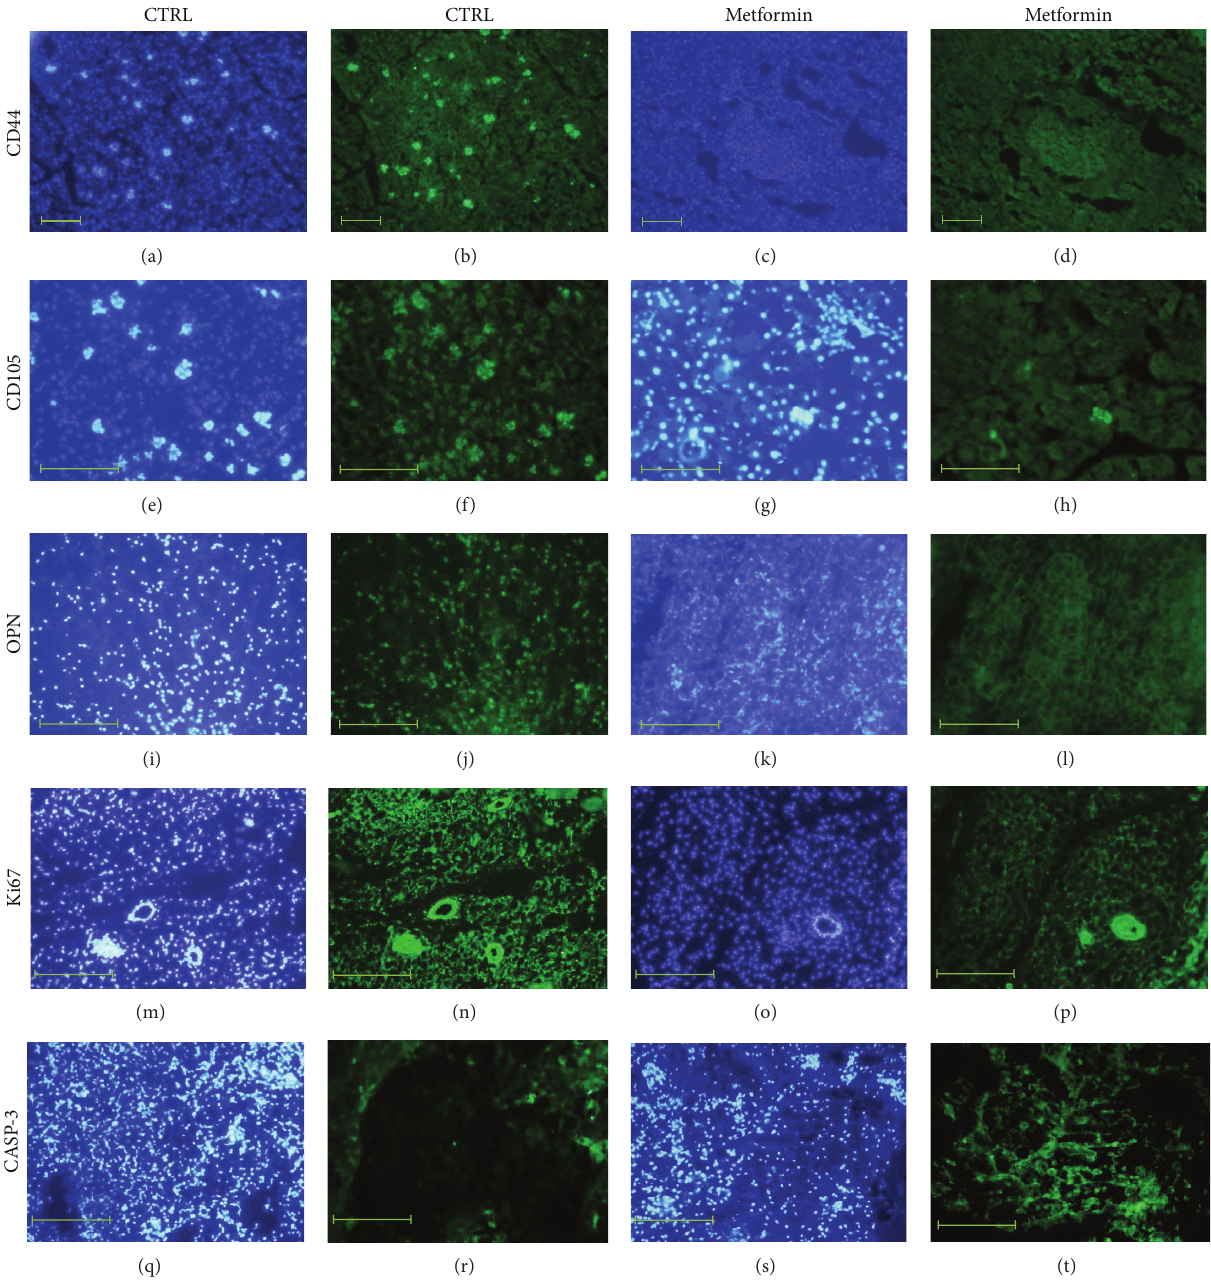
Figure 11: Results of immunohistochemical staining for CD44, CD105, OPN, Ki67, and caspase-3 (CASP-3). In order to recognize the nuclei location,theimagesofspecificstainingwerearrangedwithimagespresentingresultsofDAPIstaining(blue-toneimages).TheweakerCD44 + , CD105 + , OPN + , and Ki67 + reactions were noted in subcutaneous fat tissues collected from experimental group. Stronger positive reaction for caspase-3 was seen in fat biopsies derived from animals treated with metformin than in control group. Immunostaining reactions were prepared in duplicate. Magnifications are 50x and 100x; scale bar is 400 𝜇